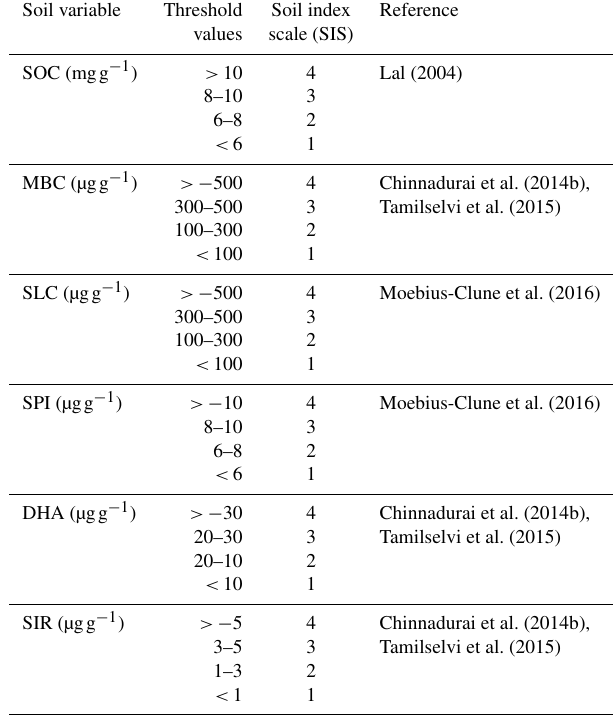
Table 2. Soil biological quality indicators, their threshold values, and corresponding score values used for